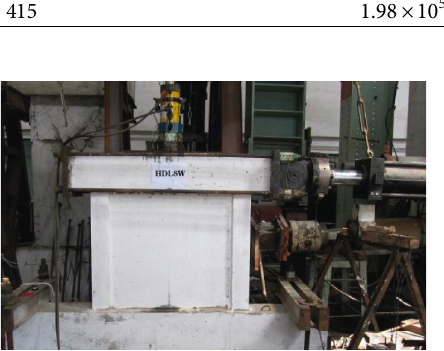
Figure 5: Loading